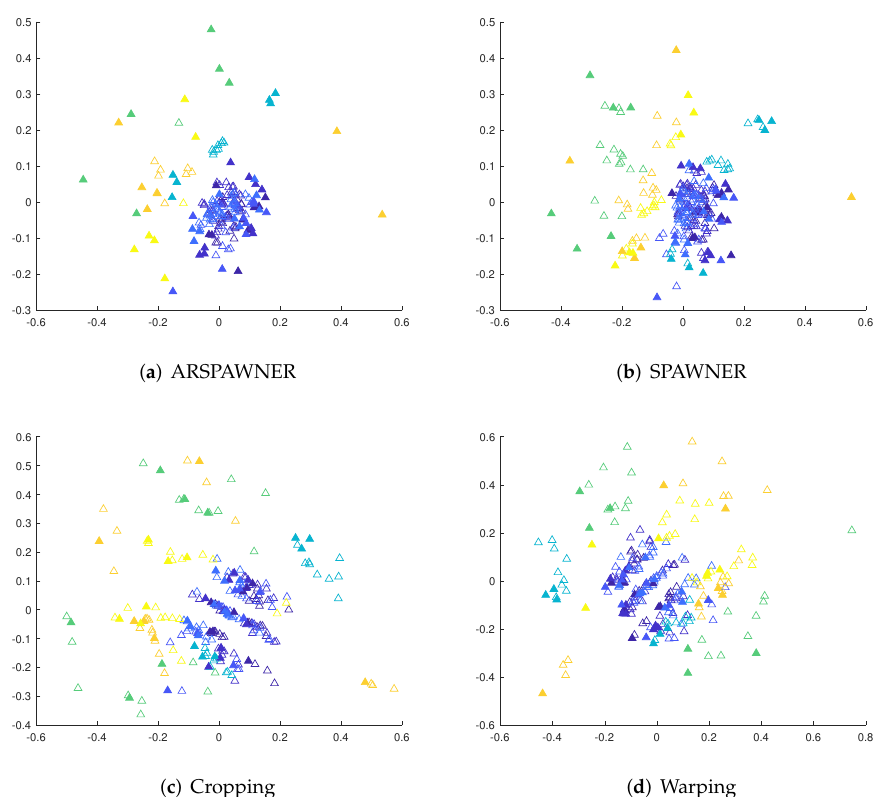
Figure 5. The 2D MDS embeddings of DTW dissimilarities between training and augmented se- quences from the MSRA I dataset for the compared augmentation methods. Colors are used to differentiate the classes, the filled triangles denote input examples.